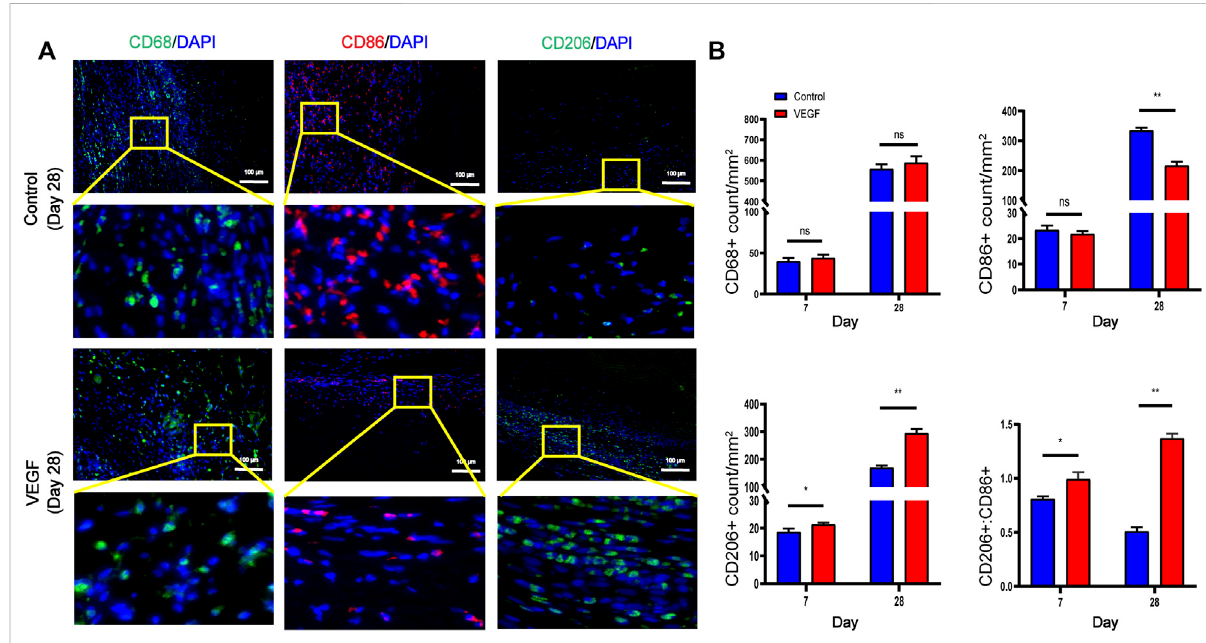
FIGURE 6 Representative immuno fl uorescence images of subcutaneous implants at day 28 in each group (A) . CD68 and CD206 stained in green, CD86 stained in red. Quanti fi cation of CD68 + total macrophages, CD86 + M1-macrophages, CD206+ M2-macrophages and M2/M1 (CD206+/ CD86+) ratio (B) . * p < 0.05. ** p < 0.01. ns represents no signi fi cant difference.